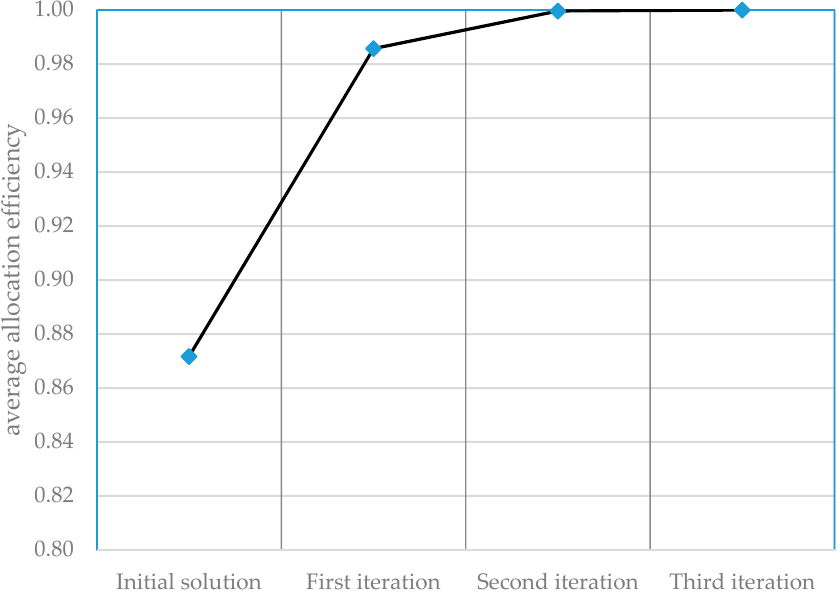
Figure 3. Average e ffi ciency of flood drainage right Figure 3. Average efficiency of flood drainage right allocation.